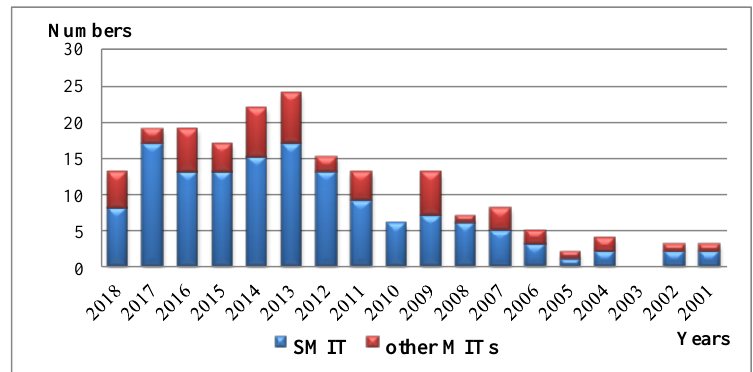
Figure 1. The annual numbers of journal publications on SMIT and other MITs from 2001 to 2018 (originated from Web of Science TM ) via searching publications including “TiO 2 molecular imprint” and “TiO 2 surface molecular imprint” (SMIT) in the topic.